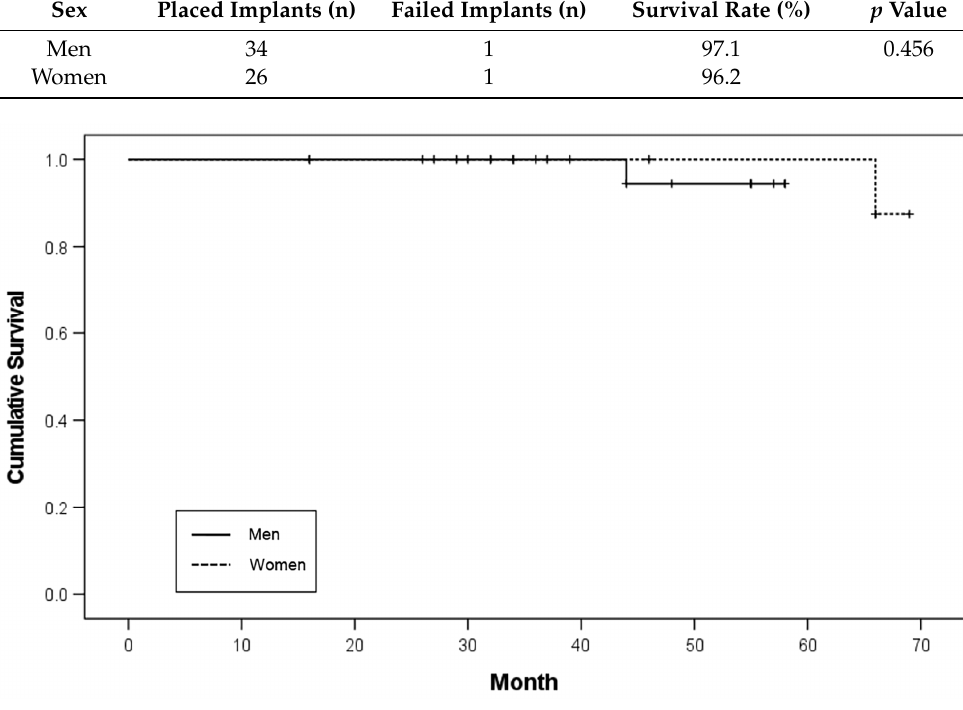
Figure 1. Kaplan-Meier survival curve according to sex.